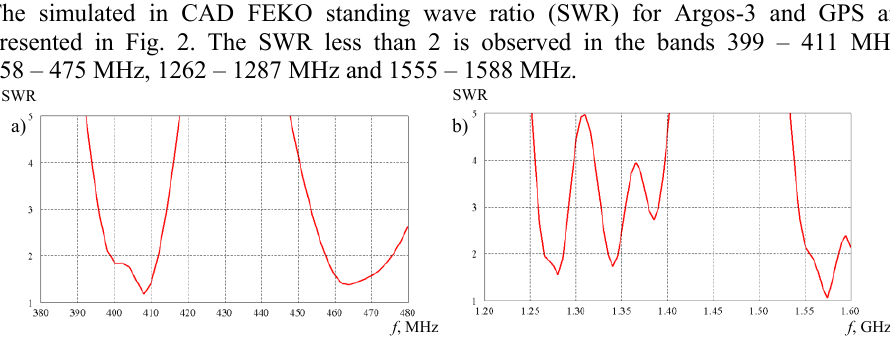
Fig. 2. Simulated SWR for Argos-3 band (а) и GPS band (b) Simulated radiation patterns for right-handed and left-handed polarizations at Argos-3 band and GPS band are presented in Fig. 3. The gain difference between the right- L1+L2 handed and left-handed polarizations is at least 10 dB. Simulated axil ratios are presented